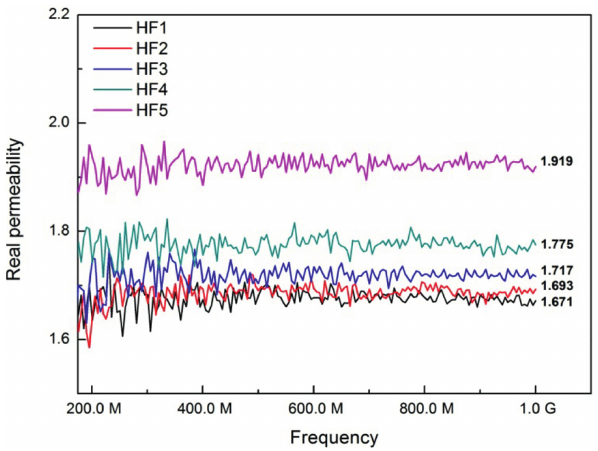
Figure 7: Real part of relative permeability versus frequency of Hf-modified